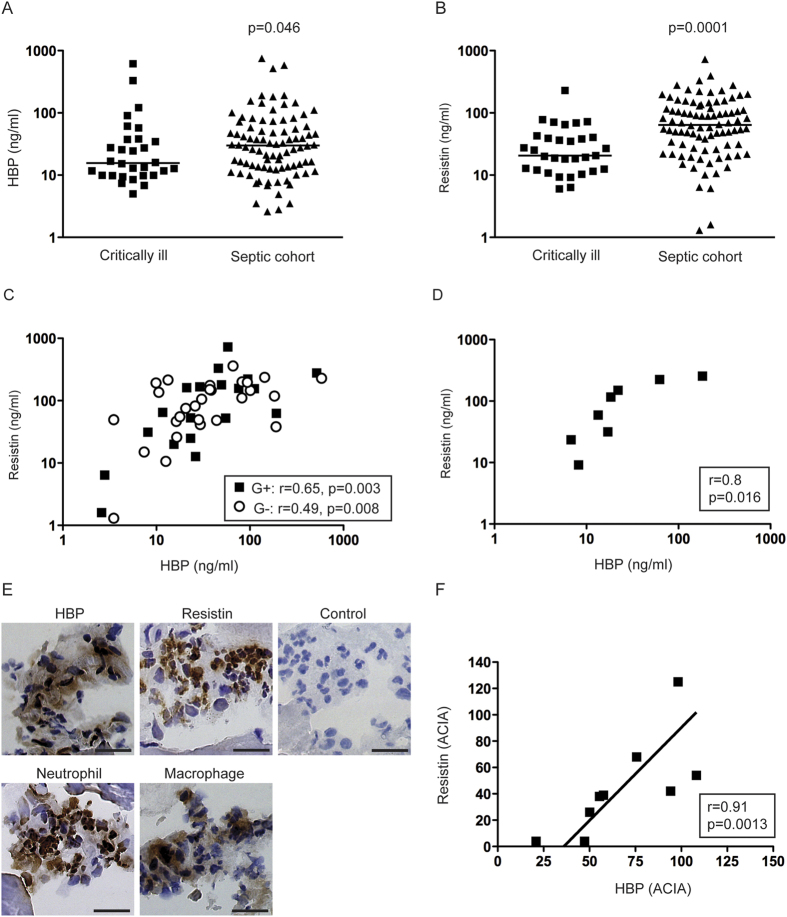
Systemic and local HBP and resistin responses in septic patients.HBP and resistin levels in plasma collected from patients on the day of inclusion were measured with ELISA, for details see Experimental procedures. (A,B) HBP and resistin levels in plasma from patients with severe sepsis/septic shock (n = 88) or non-infected critically ill patients (n = 31). (C) Plasma HBP and resistin levels in severe sepsis/septic shock patients with confirmed Gram-positive (G+) or Gram-negative (G−) infections (n = 48). (D) Systemic HBP and resistin in STSS patients (n = 8). The correlation was determined by Pearson’s correlation test, indicated by p and r-values. (E) HBP, resistin, macrophages and neutrophils were analysed by immunohistochemical staining of cryosections of snap-frozen tissue biopsies (n = 9) from patients with severe soft tissue infections caused by GAS. A control staining where the primary antibody was omitted was also performed (control). A representative tissue biopsy is shown. The scale bar indicates 50 μm. (F) The stainings were evaluated by microscope and acquired computerized image analysis (ACIA), for details see Experimental procedures. Significant correlation was determined by Spearman test, indicated by p- and r-values.